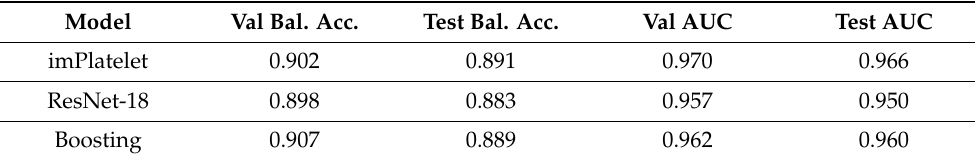
Table 3. Results of evaluated